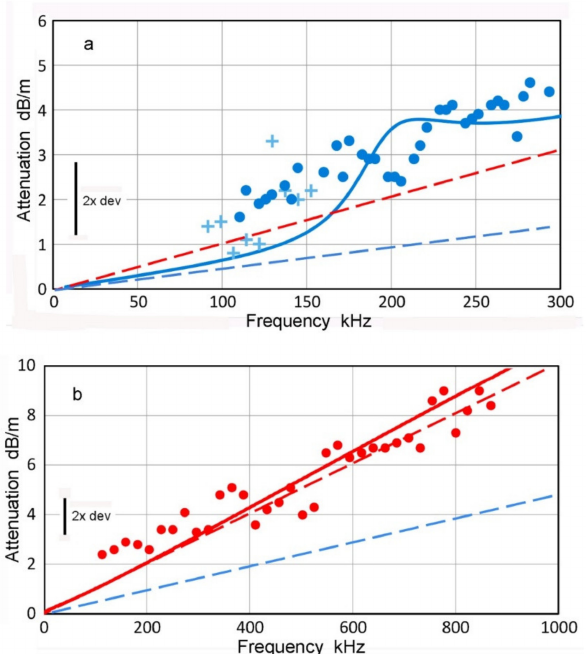
Figure 8. ( a ) α –S o values for Al-6061 plate of 12.7-mm thickness. Blue + symbols are for the data with 100-kHz excitation, while blue dots used 200-kHz excitation. Tx: AET FC500, Rx: KRN-BB-PC. Calculated α –S o (solid blue curve), α L and α T (blue and red dashed lines) are also plotted. Vertical bar shows 2 × dev. ( b ) α –A o values for Al-6061 plate of 12.7-mm thickness. Red dots are for the data using short-pulse excited AET FC500 as Tx and KRN-BB-PC as Rx. Calculated α –A o (solid red curve), α α L and T (blue and red dashed lines) are also plotted. Vertical bar shows 2